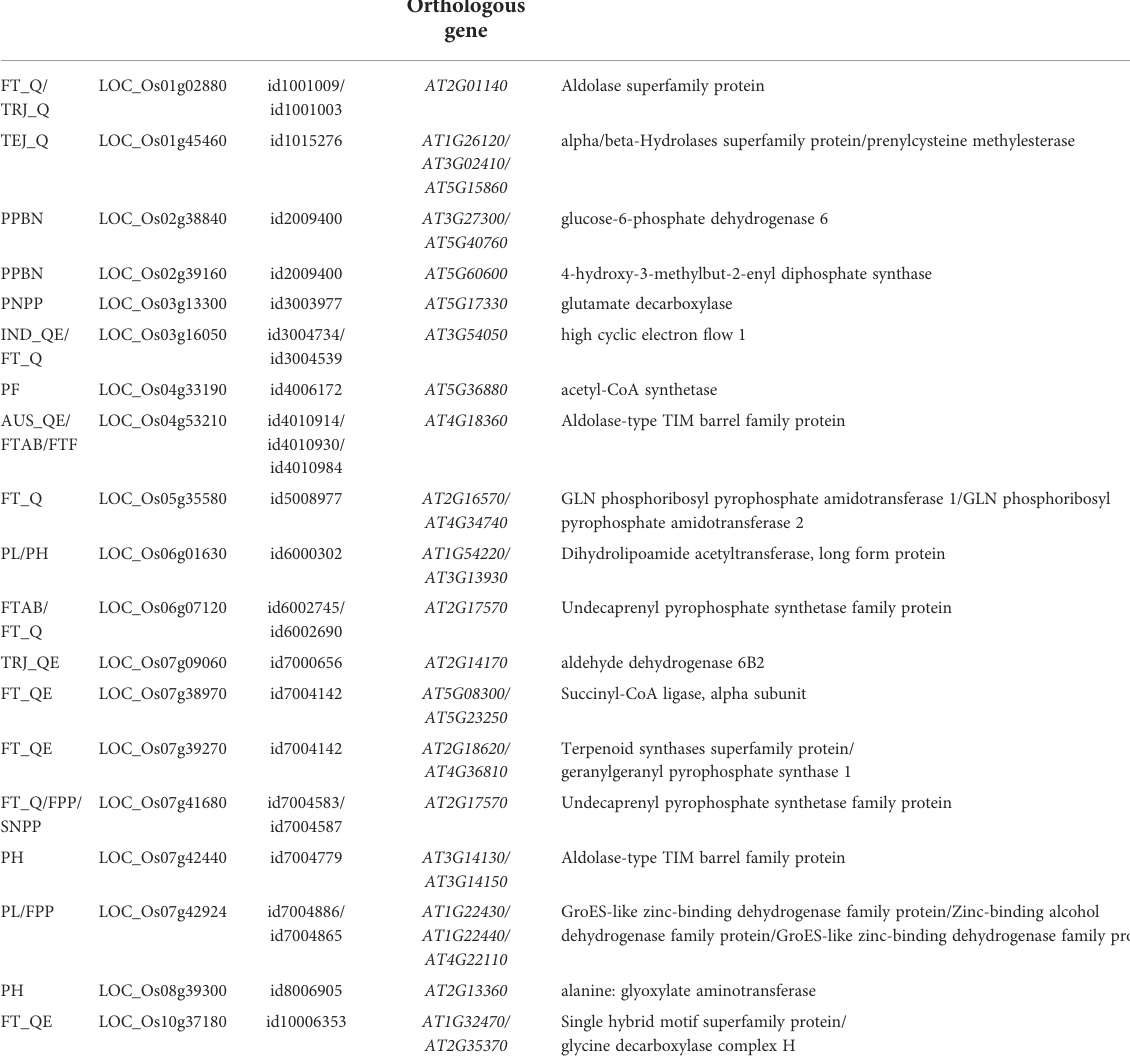
TABLE 5 Orthologous information of candidate genes with higher tissue expression.